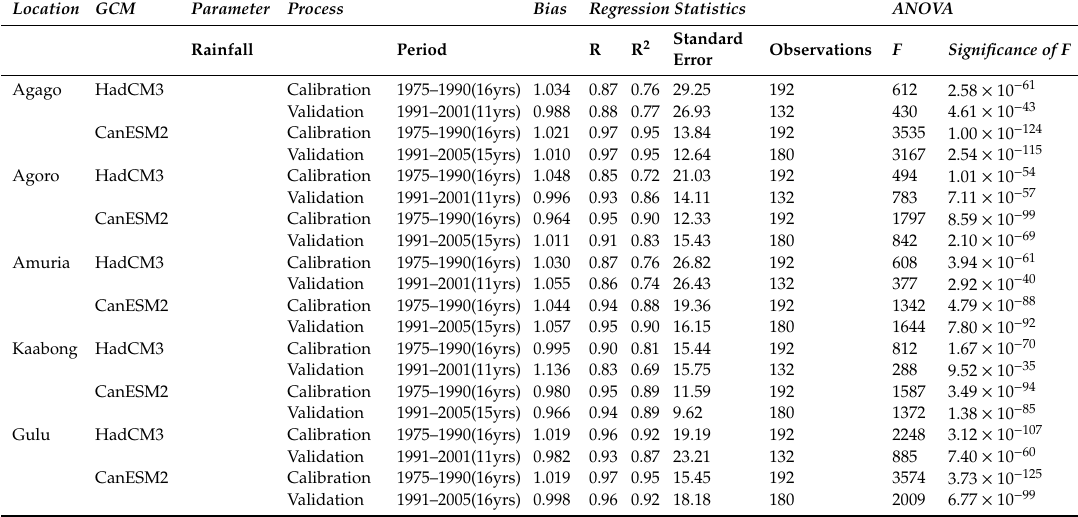
Table 3. Calibration and validation of Statistical down Scaling Model (SDSM) results for various locations within the Aswa